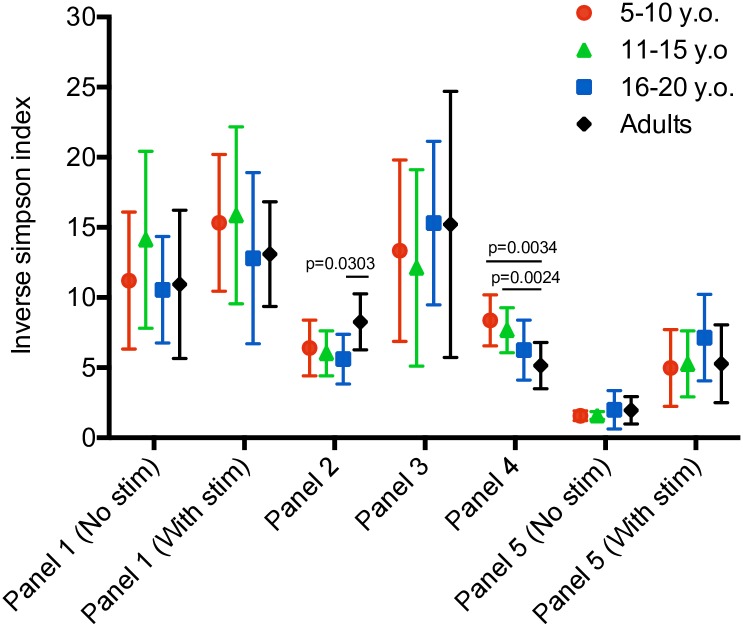
Quantification of NK cell diversity based on combinatorial expression of individual receptors.Inverse Simpson indices are indicated for each panel and stratified by age group. Index values are representative of total number of distinct panel-wise combinatorial NK subsets found in each donor (diversity). The combinatorial subsets were previously computed using treeplot analysis. All data shown is median ± S.D. 5–10 y.o. (n = 15) (red); 11–15 y.o. (n = 15) (green); 16–20 y.o. (n = 15) (blue) and adults (n = 20) (black).